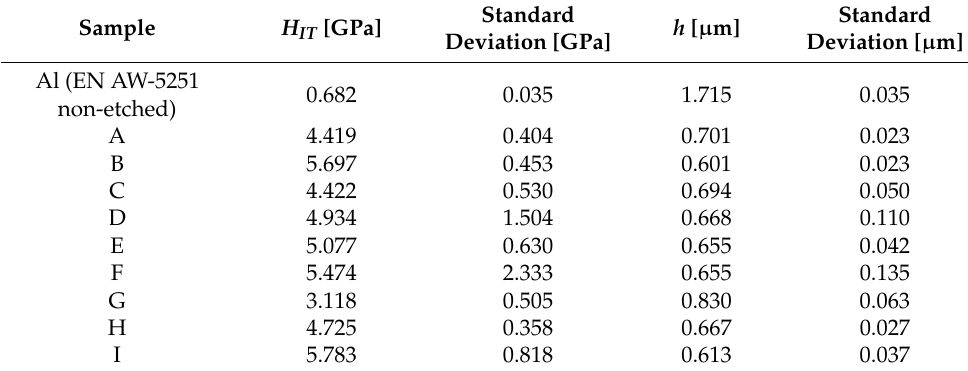
Table 5. Microhardness of studied layers and maximum indentation depth.